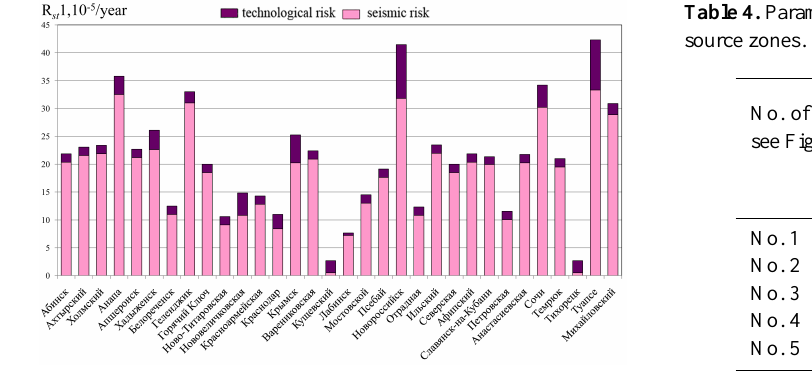
Fig. 3. Distribution of seismic risk R st 1, taking into account sec- ondary technological accidents triggered by earthquakes for the set- tlements of the Krasnodar region. Table 3. Extent of zones with different risk levels for the Krasnodar area.